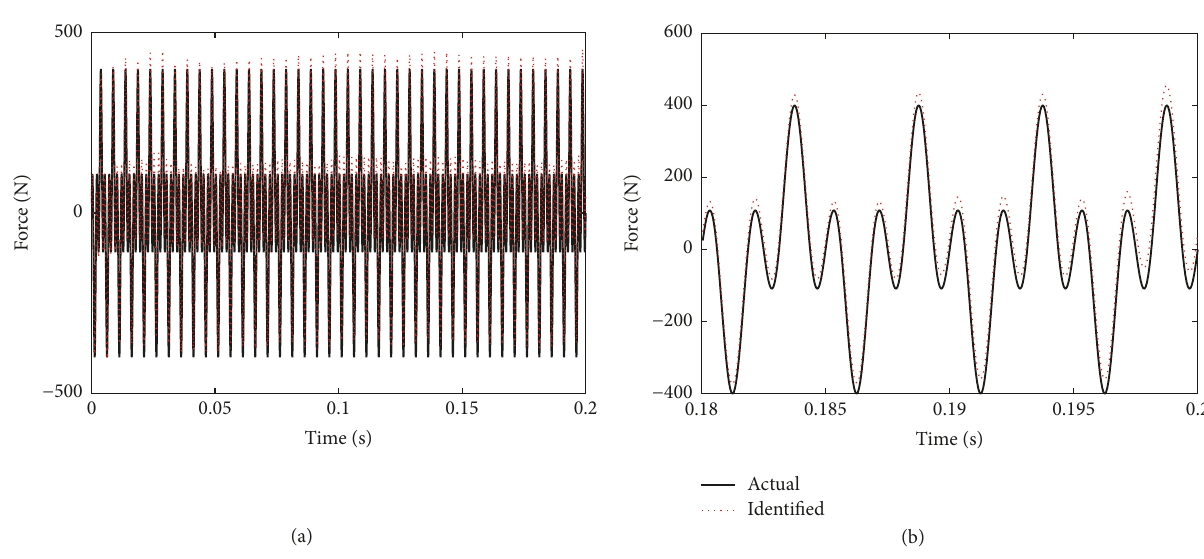
Figure 12: The actual and identified results of force 𝑢